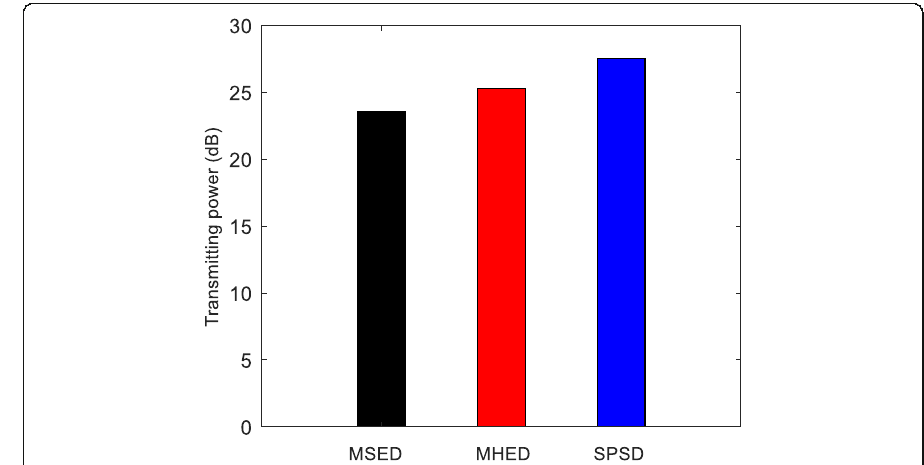
Fig. 6 The transmitting power achieved by the three optimization schemes. The black histogram represents the transmitting power achieved by MSED, which is the scheme proposed in reference 18; the red histogram represents the transmitting power achieved by MHED which is the scheme proposed in reference 19; the blue histogram represents the transmitting power achieved by SPSD the optimization scheme proposed by this paper